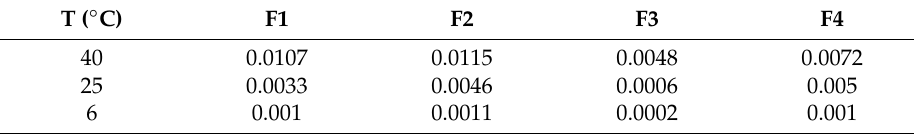
Figure 4. Chemical stability of HQ formulations upon storage at different temperatures expressed as ( a ) HQ degradation and ( b ) p-benzoquinone (pBQ) formation. Table 3. Degradation constants (percentage of degraded HQ/day) at different storage conditions.